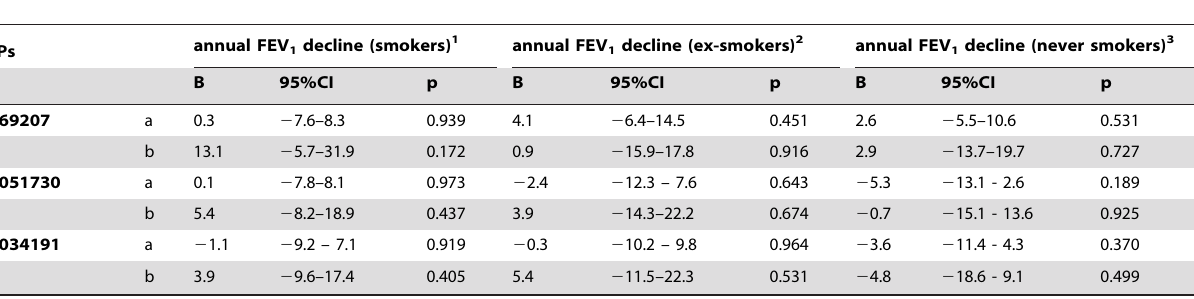
Table 2. SNPs in the nAChR cluster and annual FEV 1 decline (ml/year) in smokers, ex-smokers and never smokers.